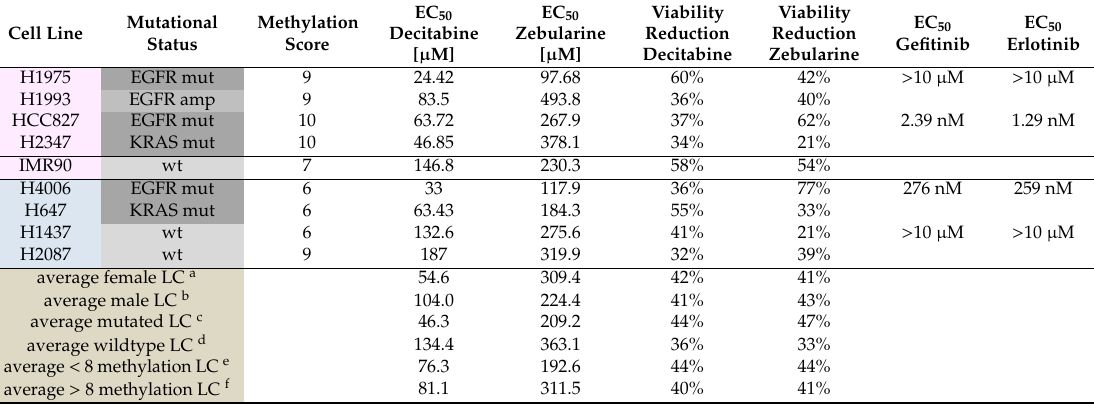
Table 4. Summary of the EC 50 values and viability reductions achieved for the lung cancer (LC) (IMR90 is benign) cell lines treated with the DNA methyl-transferase inhibitors (DNMTIs) decitabine and zebularine. For H1975, HCC827, HCC4006, and H1437, additional EC 50 values for tyrosine kinase inhibitor (TKI) treatments with gefitinib and erlotinib are shown. Student’s t-test gave no statistically significant p -value comparing viability reduction and EC 50 values for female vs. male cancerous cell lines (decitabine: p = 0.22, zebularine: p = 0.41). A statistically significant di ff erence between the decitabine EC 50 values of mut versus wt cell lines was found ( p = 0.01). No statistical significance was reached for zebularine ( p = 0.12) (Figure 4). A Mann–Whitney U test for the EC 50 values of cancerous cell lines with methylations scores > 8 compared to cancerous cell lines with methylation scores < 8 showed no statistically significant di ff erence for neither decitabine ( p = 1.0) nor zebularine ( p = 0.39).